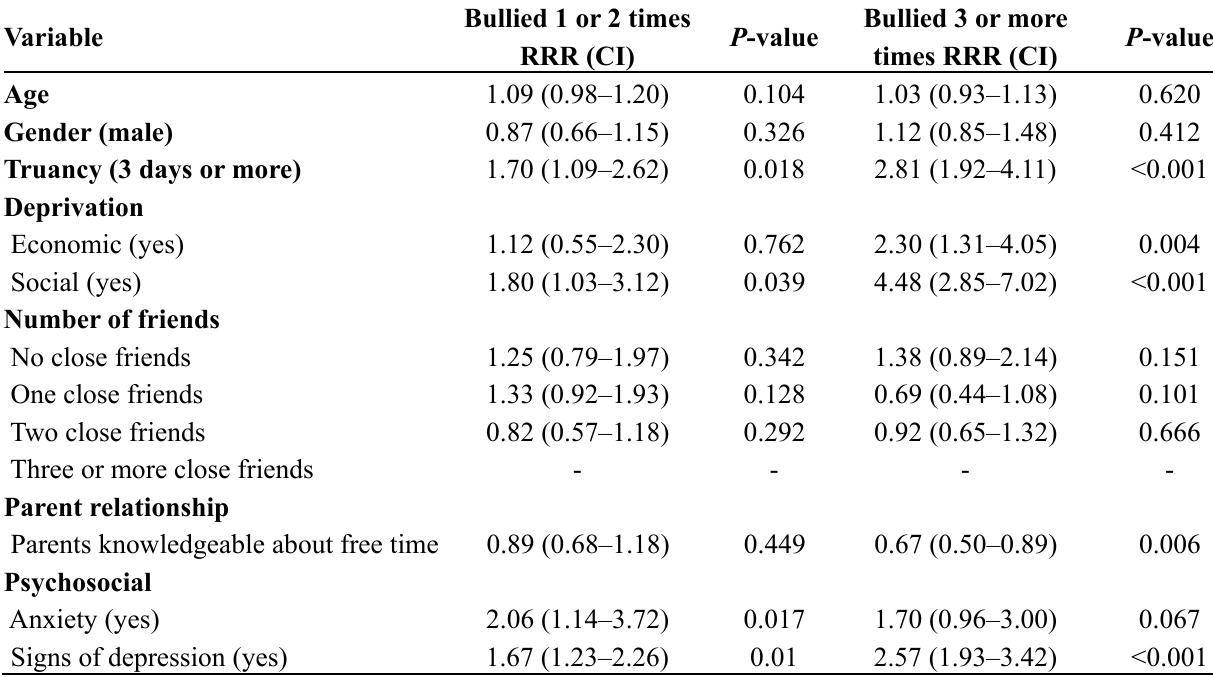
Table 5. Multinomial logistic regression analysis by bullied